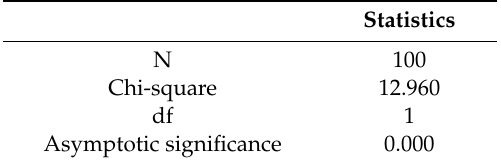
Table 27. Friedman’s test—for two components of CRII.